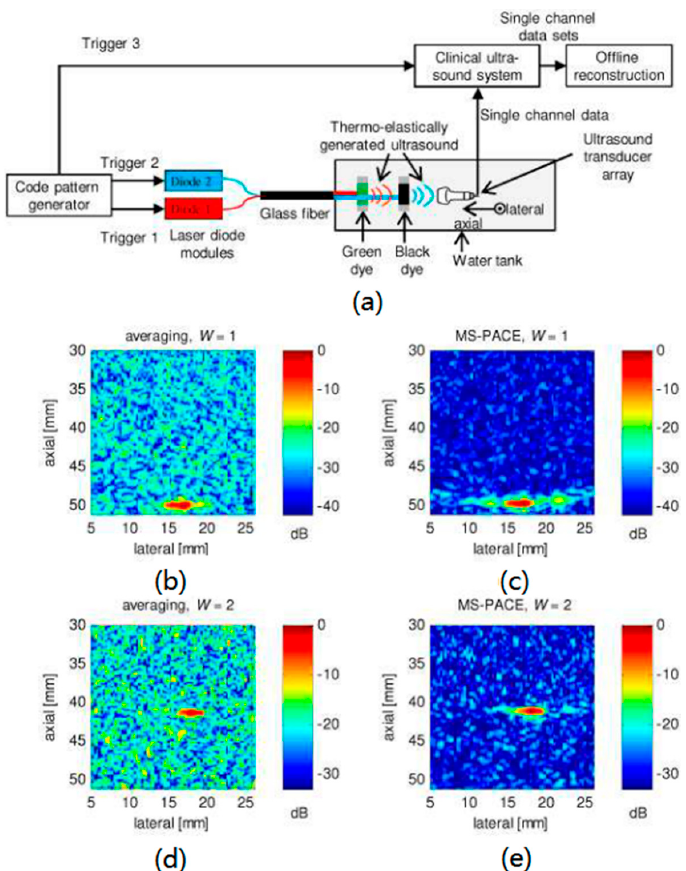
Figure 13. ( a ) Experimental setup for MS-PACE. ( b – e ) Comparison of MS-PACE and time equivalent averaging for both excitation wavelengths. ( b ) PA image for averaging as many acquisitions as possible during the coding procedure for W = 1, termed time-equivalent averaging. ( c ) PA image using MS-PACE for W = 1. ( d ) PA image using time-equivalent averaging for W = 2. ( e ) PA image using MS-PACE for W = 2. Reproduced with permission from Ref. [76].